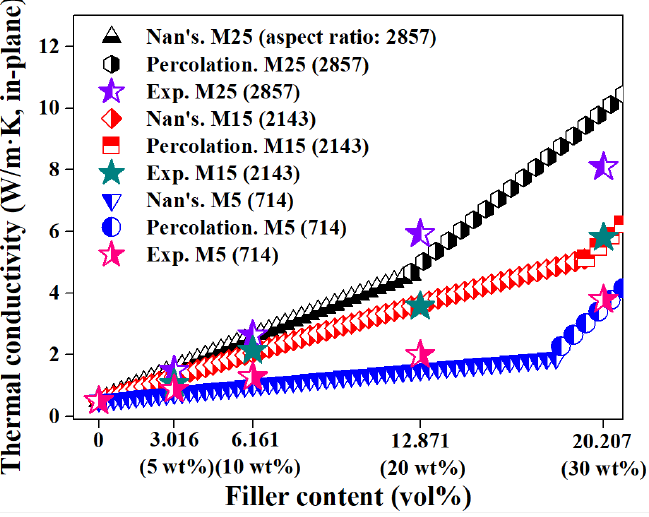
Figure 2. Experimental and theoretical thermal conductivity of the fabricated composites.